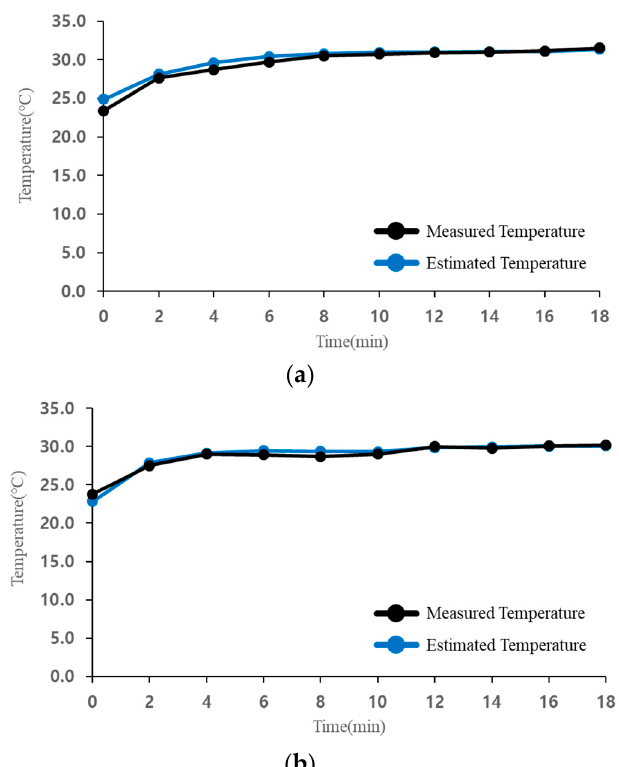
Figure 15. Stator winding temperature estimation results at ( a ) no load; ( b ) fluid load.